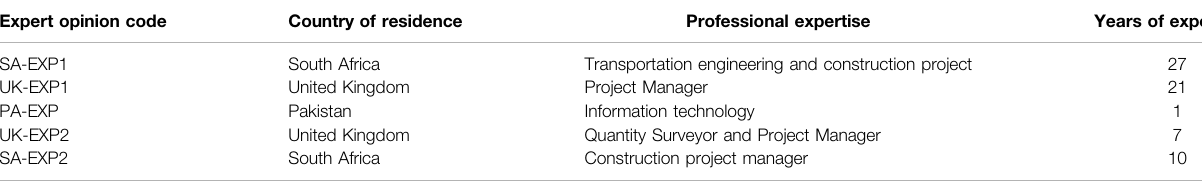
TABLE 2 | Pro fi le of the experts who provided their opinions in the validation phase. Source: Authors.